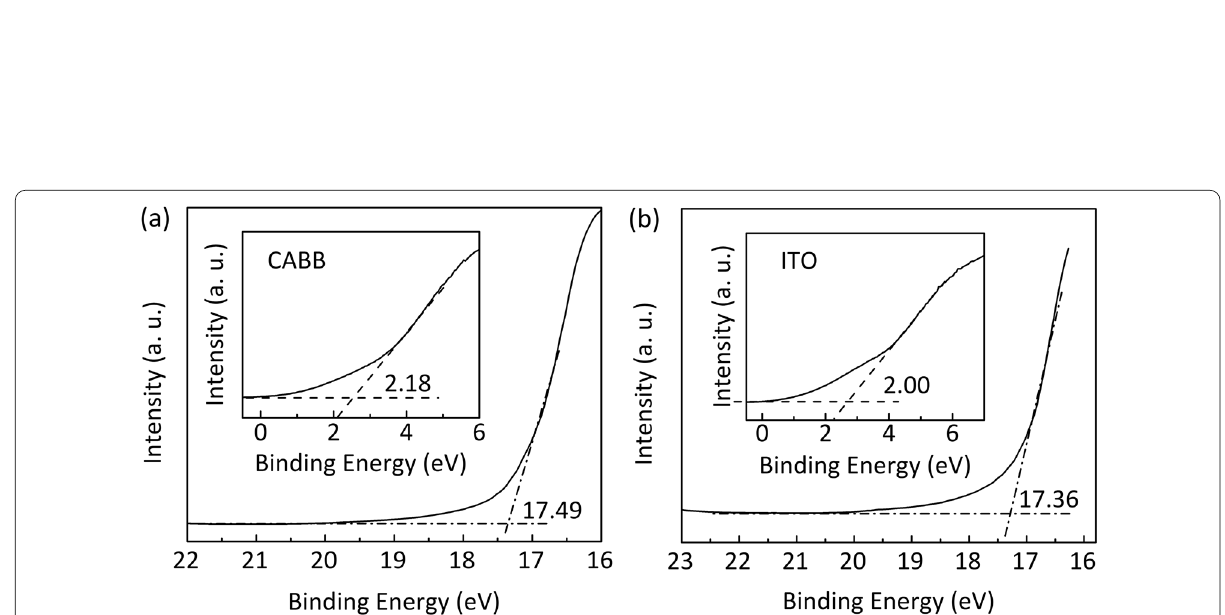
Fig. 6 The electric conductive process and the schematic band diagram of the Pt/CABB/ITO/glass device in the ( a ) and b absence, c presence of light